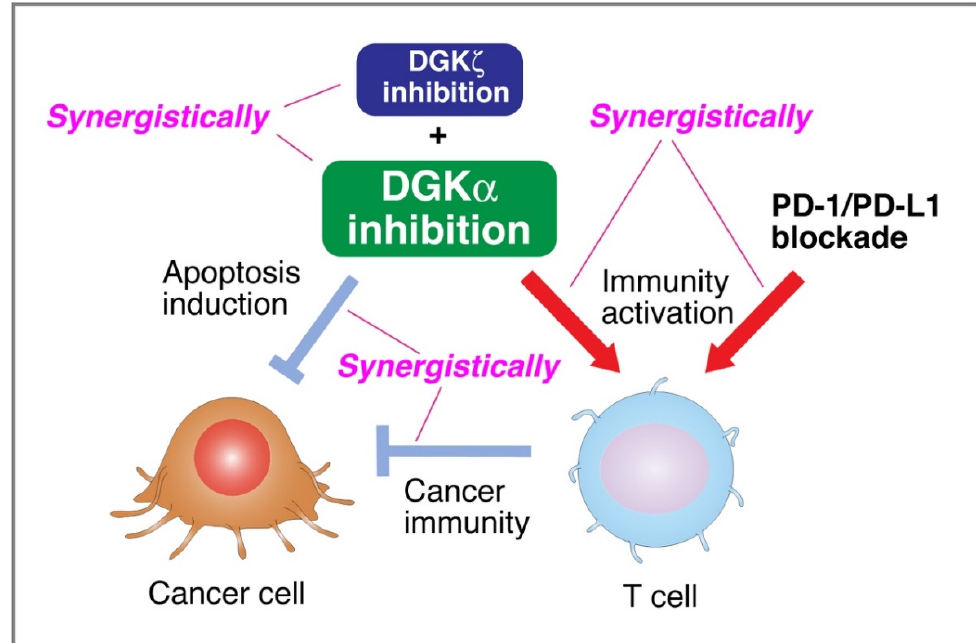
Figure 3. DGK α -selective inhibitors would be dual effective anticancer medicines that inhibit cancer cell proliferation and simultaneously activate T cell function. It is likely that apoptosis induction of cancer cells (direct effect) and cancer immunity (indirect effect) induced by DGK α inhibition synergistically cause damage to cancer cells. Moreover, the inhibition of DGK ζ can synergistically enhance the effects of DGK α inhibition. Furthermore, the cooperative effect observed after PD-1/PD-L1 blockade and DGK α inhibition offers a promising strategy to improve the efficacy of immunotherapy in the treatment of cancer.